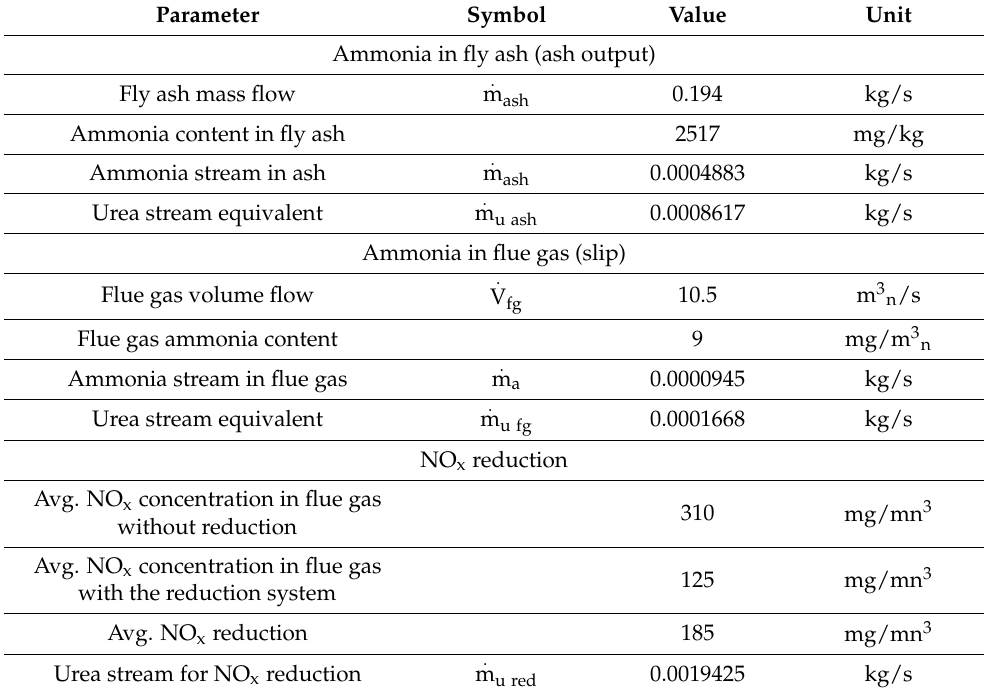
Table 5. Parameters of outcoming ammonia